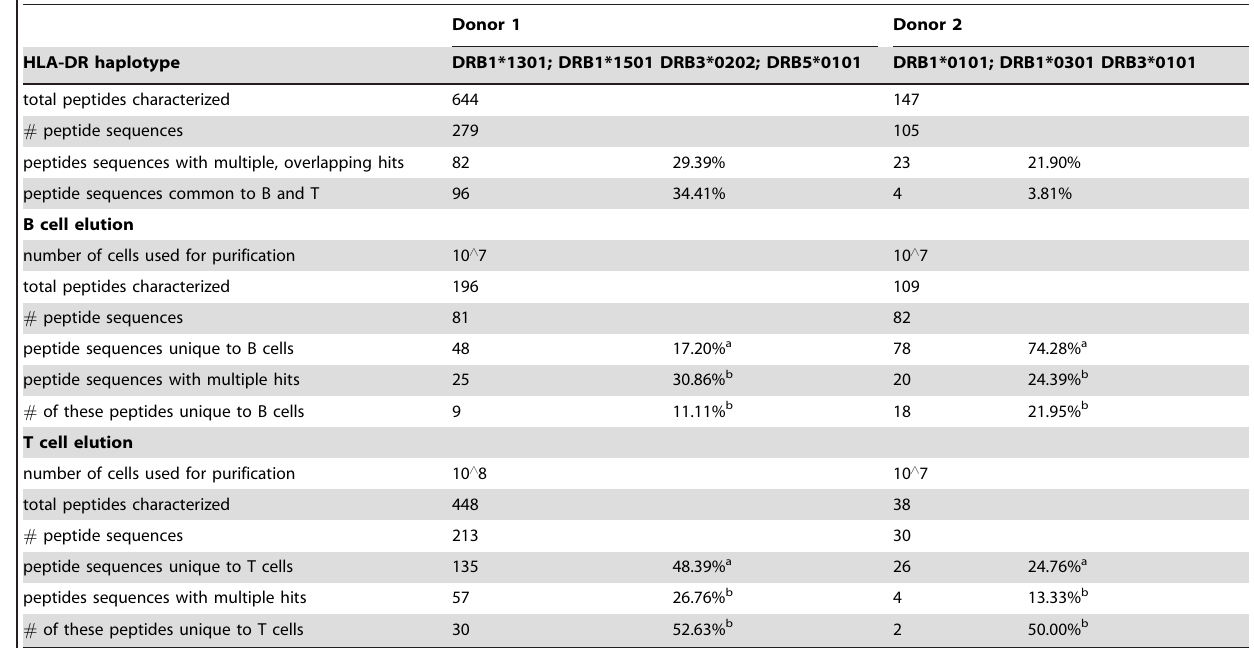
Table 1. Number and frequency of peptides